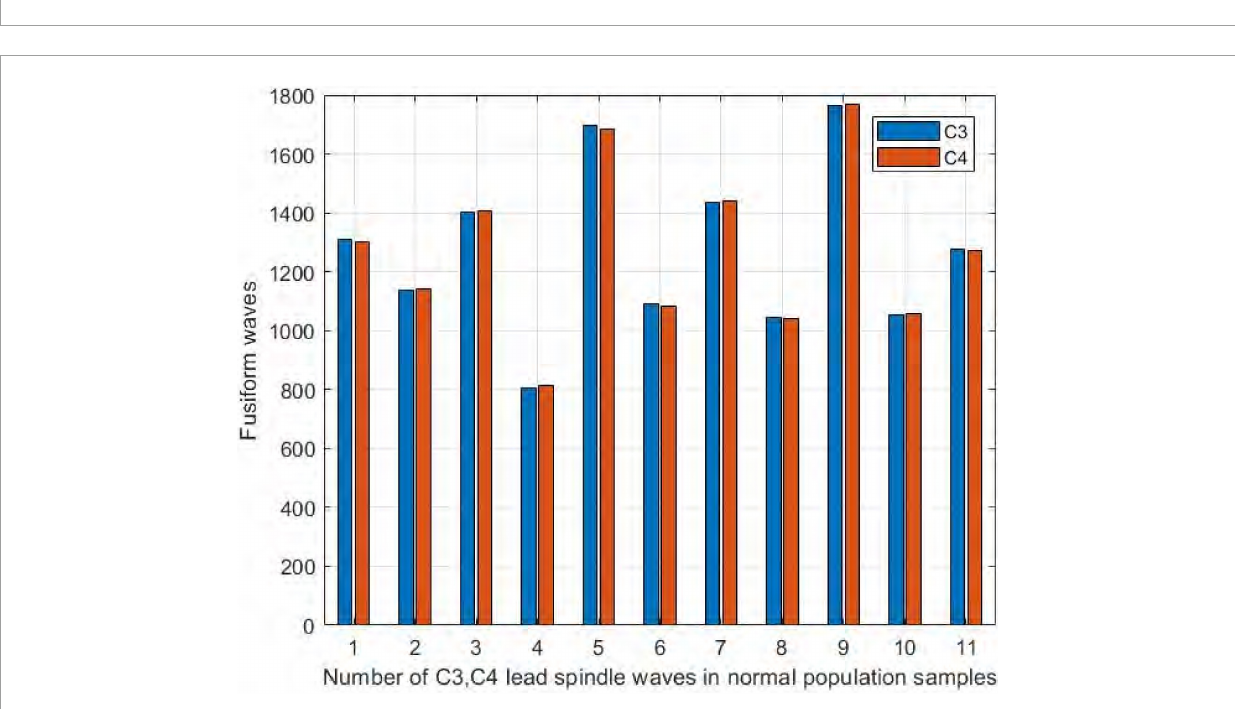
FIGURE11 Comparison of the number of spindles in C3 and C4 channels in normal